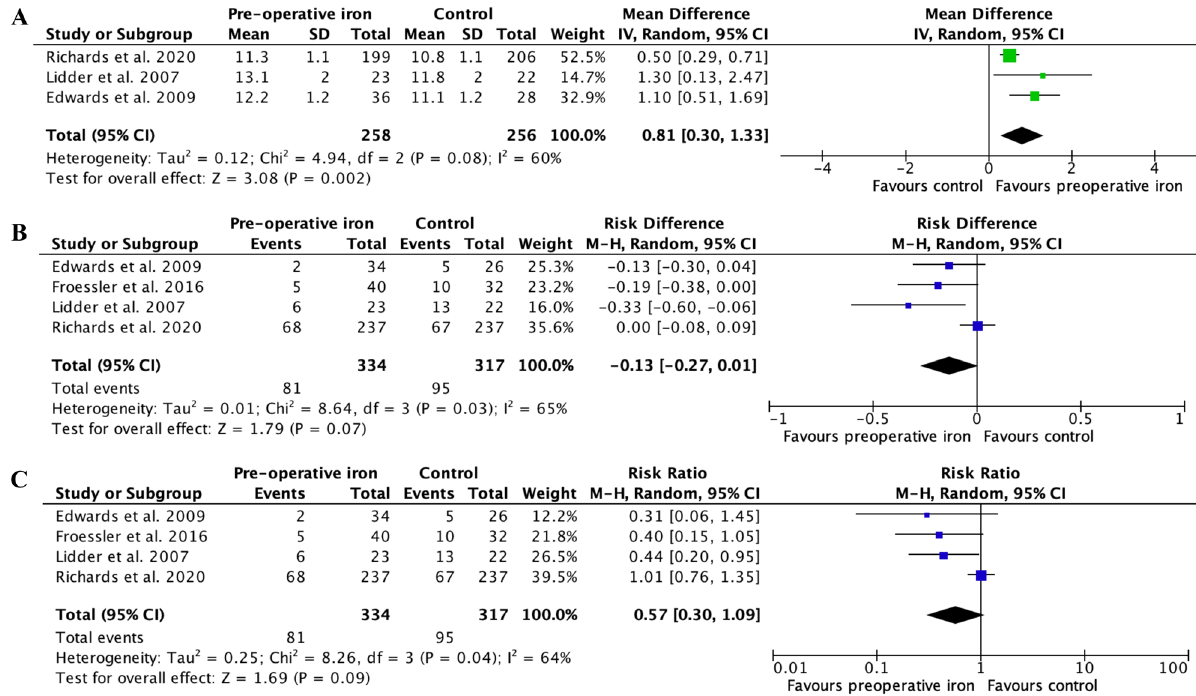
Figure 2. Meta-analysis of the role of pre-operative iron on anaemia outcomes in patients undergoing abdominal surgery. Forest plot comparing pre-operative iron versus no pre-operative iron or placebo before abdominal surgery. Each horizontal bar summarizes a study. The bars represent 95% confidence intervals. The grey squares inform on each of the studies’ weight in the meta-analysis. The diamond in the lower part of the graph depicts the pooled estimate along with 95% confidence intervals. Pooled relative risk (RR), risk difference (RD) and mean difference (MD) were obtained using models with random effects. Heterogeneity was assessed using the Q-test and quantified using the I 2 value. Risk of bias was assessed by using the Cochrane Collaboration’s tool for assessing risk of bias. ( A ) MD in haemoglobin concentration at admission, ( B ) RD for peri-operative allogeneic blood transfusion, ( C ) RR for peri-operative allogeneic blood transfusion. Data for the RCT by Richards et al. were extracted from Table 2 of their article including large blood transfusions for the number of patients who received blood transfusion, and reconstituted from the text (which reported a MD of 4.7 g/l and from Figure 2 for the mean haemoglobin